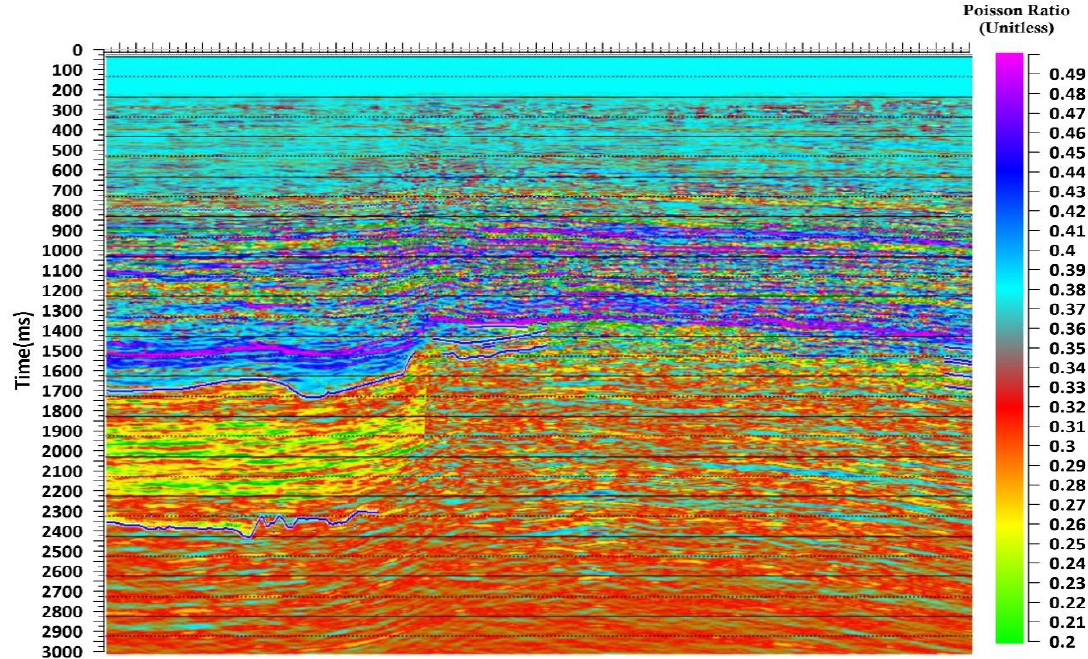
Figure 7. Poisson’s ratio of the subsurface of the North-Heera field calculated from the seismic